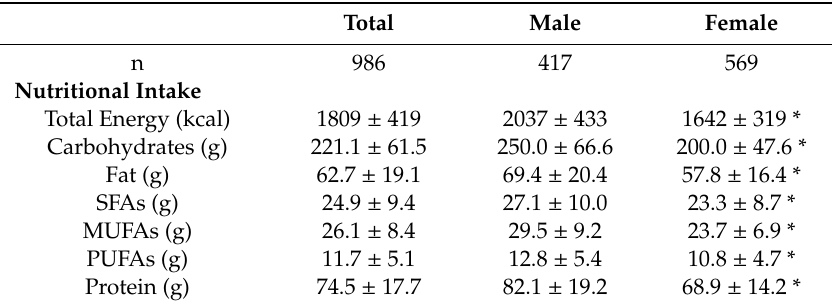
Table 2. Daily energy and macronutrient intake of the study population.